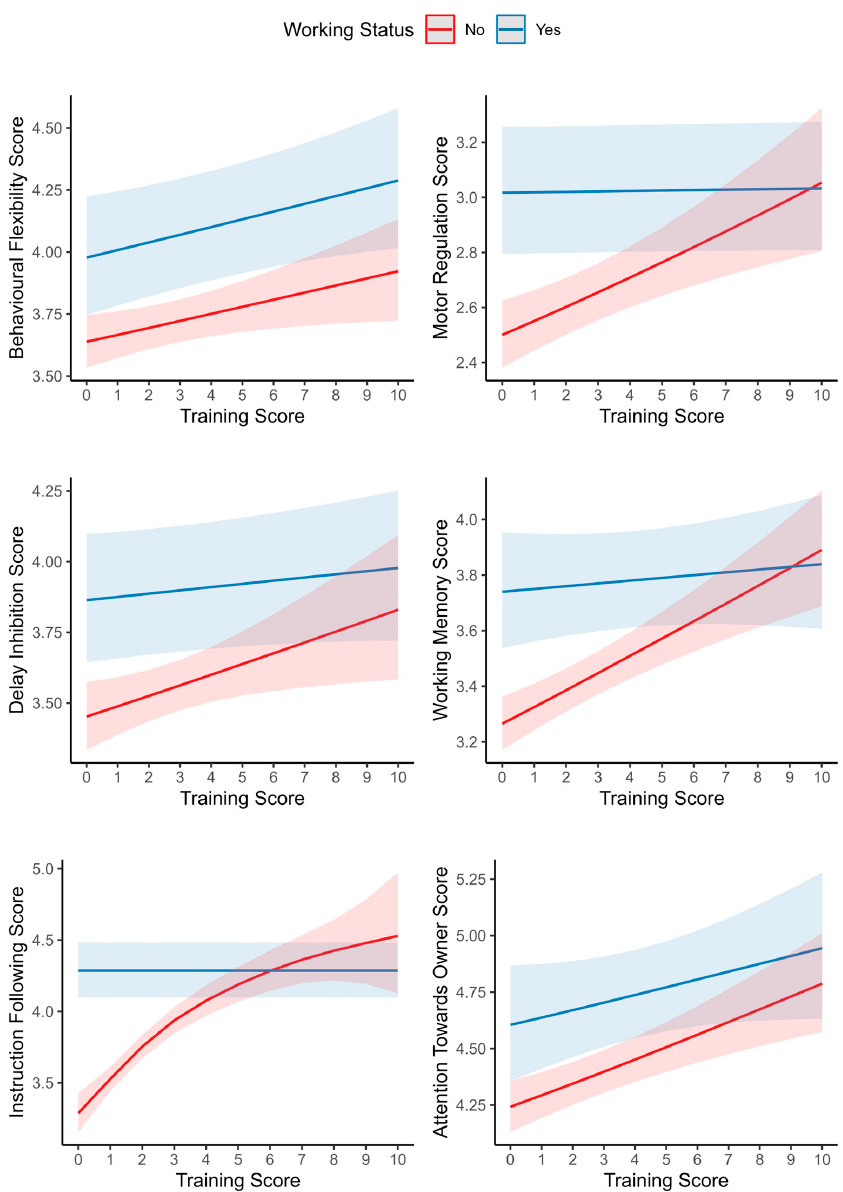
Figure 2. Estimated smoothing curves of the relationship of subscale scores and dogs’ Training Score by Working Status. Solid lines are the smoothers and shaded regions indicate 95% confidence intervals. GAMs indicated significant relationships between sex and reproductive status with Table 4. p -values of pairwise Wilcoxon tests between different sex/reproduction status groups. the subscale scores Working Memory, Behavioural Flexibility and Motor Regulation. To p -values printed in bold are investigate group differences, pairwise Wilcoxon tests were performed with the correction of p -values according to Benjamin and Hochberg [46] (see Table 4). Intact females (mean = 4.04, SD = 0.85) and intact males (mean = 3.98, SD = 0.79) scored significantly higher than desexed males (mean = 3.74, SD = 0.86) in Behavioural Flexibility. Intact (mean = 2.69, SD = 0.89) and desexed (mean = 2.67, SD = 0.87) males scored significantly lower than spayed